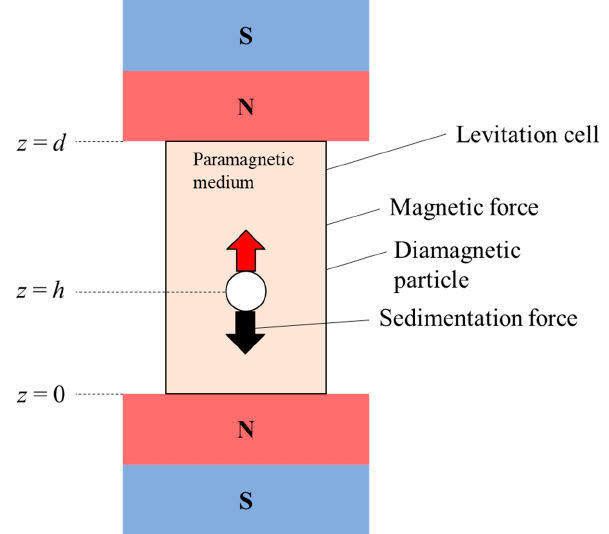
Figure 4. Representative setup of MagLev.